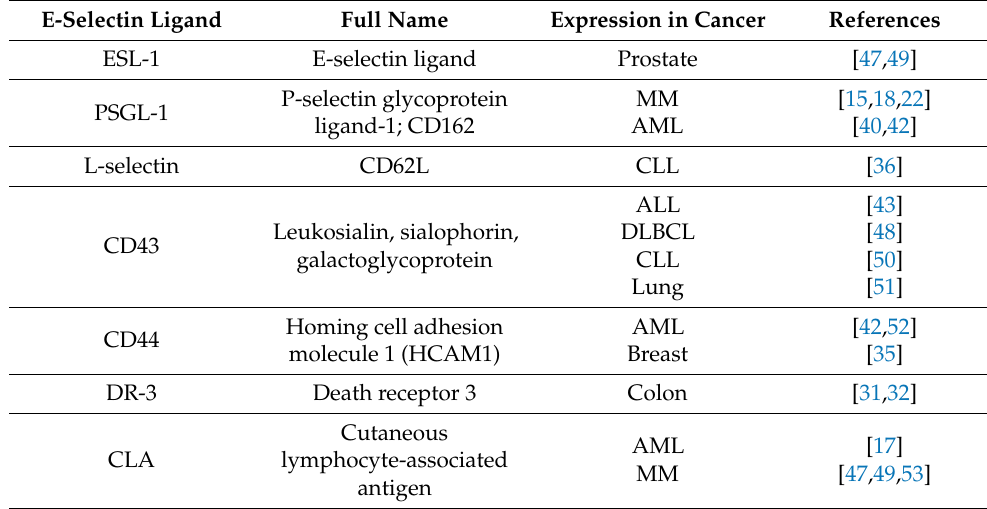
Table 1. E-selectin ligands expressed in